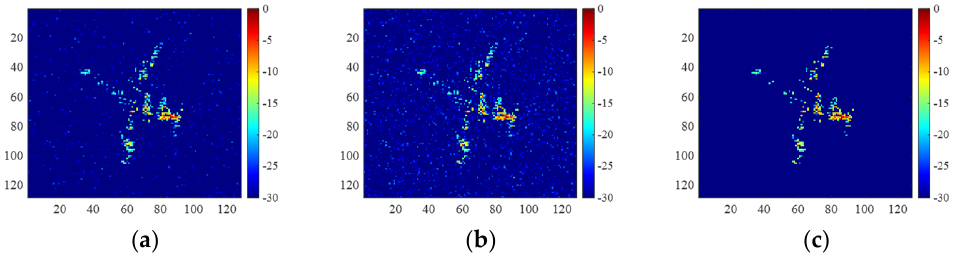
Figure 10. Yak ‐ 42 images of complete data obtained by ( a ) 2D ‐ FISTA, ( b ) untrained 2D ‐ ADN, and ( c ) trained 2D ‐ ADN. Table 3. Quantitative performance evaluation for the complete measured data.